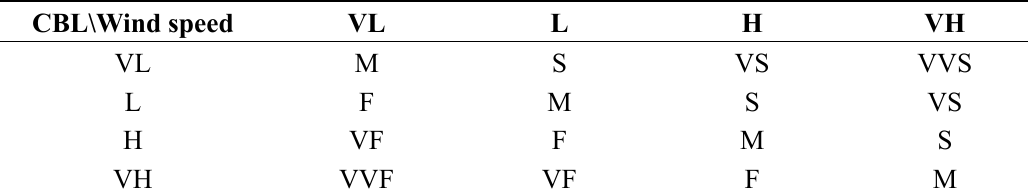
Table 3. Fuzzy rule of battery discharging for battery agent in state “3”.